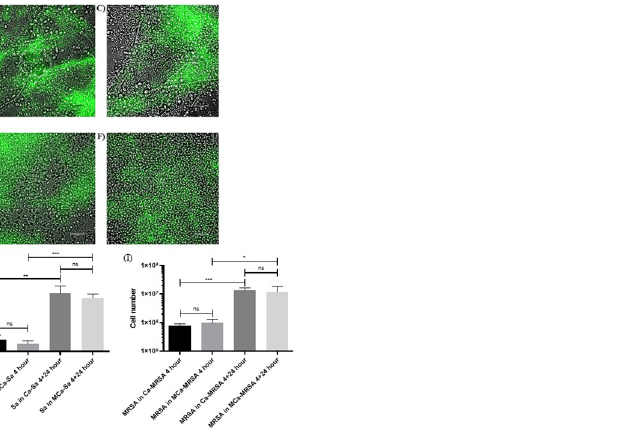
Fig 2. Dual-species biofilm formation with C . albicans wild type or hyphal-deficient mutant investigated by TIRF fluorescent microscopy and qPCR. Dual-species biofilms of (A) C . albicans NCTC 3179 and mCherry- E . coli ,(B) C . albicans NCTC 3179 and GFP- S . aureus , (C) C . albicans NCTC 3179 and GFP-MRSA. Dual-species biofilms of (D) C . albicans hyphal-deficient mutant ( Ca_gcn5 Δ / Δ )and mCherry- E . coli , (E) C . albicans hyphal-deficient mutant ( Ca_gcn5 Δ / Δ )and GFP- S . aureus , (F) C . albicans hyphal-deficient mutant ( Ca_gcn5 Δ / Δ )and GFP-MRSA. Scale bar 15 μ m. Dual species biofilms containing C . albicans wild type (NCTC 3179) (Ca) or hyphal-deficient mutant ( Ca_gcn5 Δ / Δ )(MCa) were investigated by qPCR to determine (G) E . coli (Ec), (H) S . aureus (Sa) and (I)